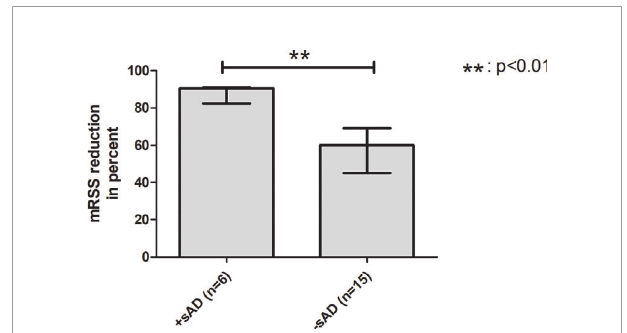
FIGURE 2 | Better cutaneous response to aHSCT is a potential risk factor for sAD. Comparison between transplanted SSc patients with development of sAD and without development of sAD. The group with onset of sAD had a higher reduction of mRSS by transplantation, indicating that better cutaneous response to aHSCT might be a risk factor for developing sAD. aHSCT, autologous hematopoietic stem cell transplantation; mRSS, modi fi ed Rodnan skin score; sAD, secondary autoimmune disease; SSc, systemic sclerosis. Error bars are given as interquartile range (IQR).